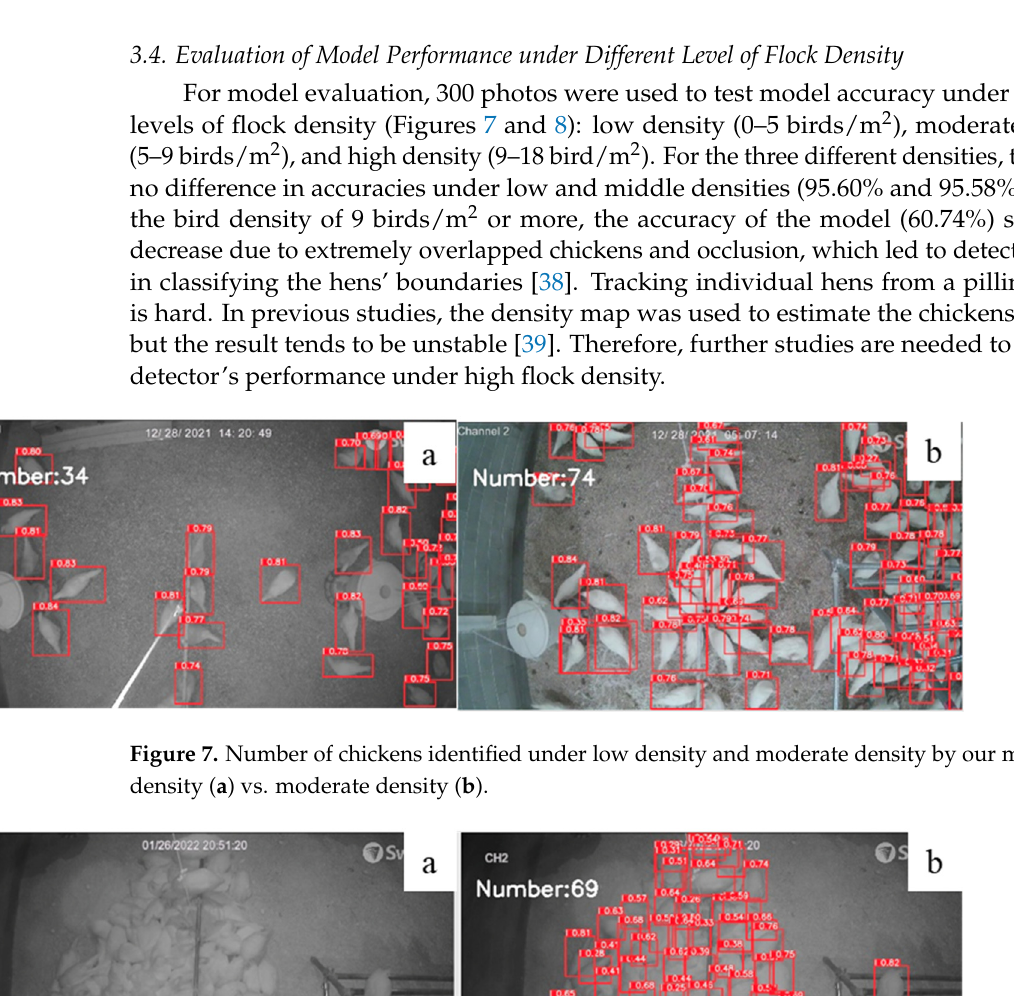
Figure 6. Number of chickens identified under different level of light intensity by our model: 10 lux ( a ) vs. 30 lux ( b ).